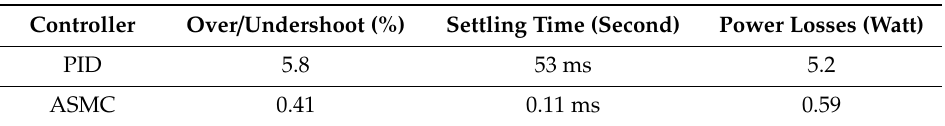
Table 7. Performance characteristics of the conventional controller and the proposed ASMC controller based in IPSM with 40